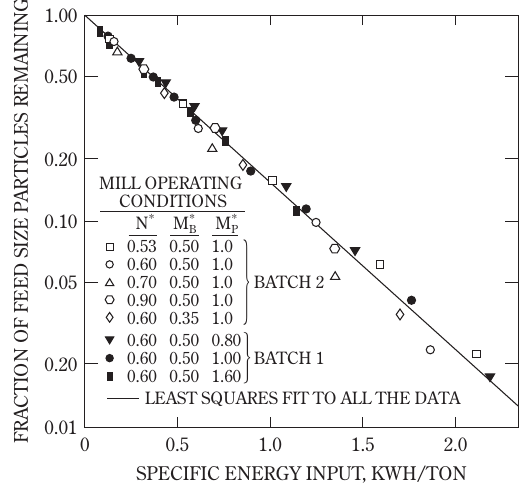
Fig. 5 Feed disappearance kinetics normalized with respent to specific energy in kWh per ton of feed